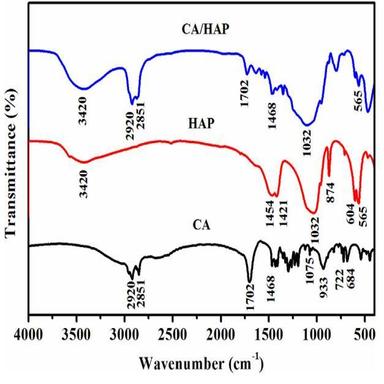
FTIR spectra of CA, HAP and CA/HAP composite.